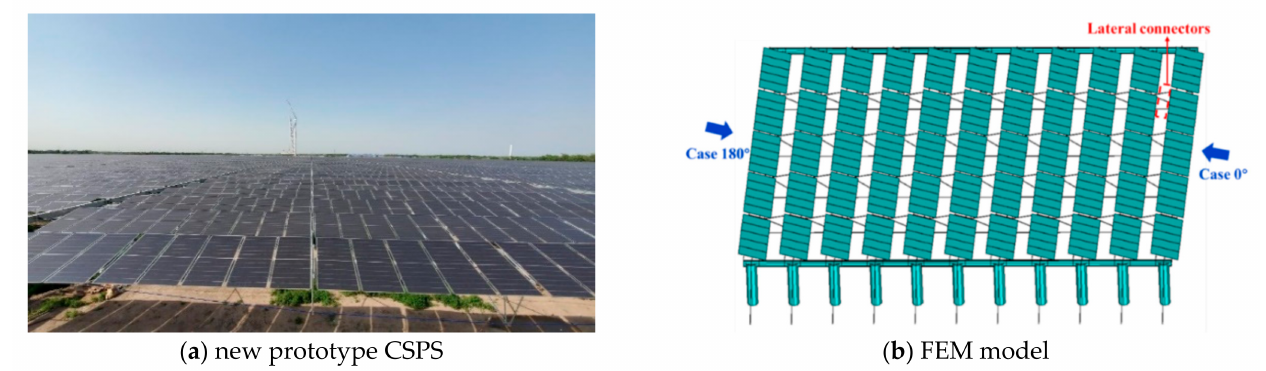
Figure 4. Overview of the new prototype CSPS and its FEM